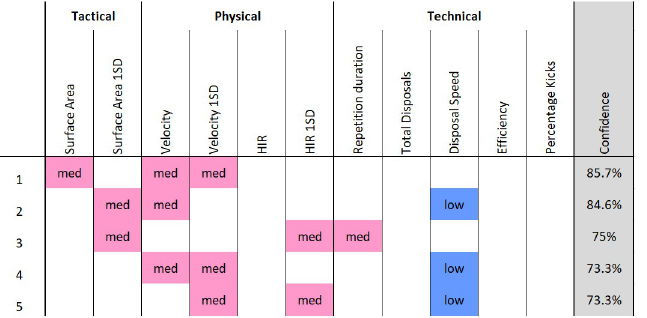
Fig 5. The top five rules generated for the disadvantage constraint condition, ordered by confidence. Each discretised metric is colour coded according to its category (red = high, pink = med, blue = low) for visual interpretability.